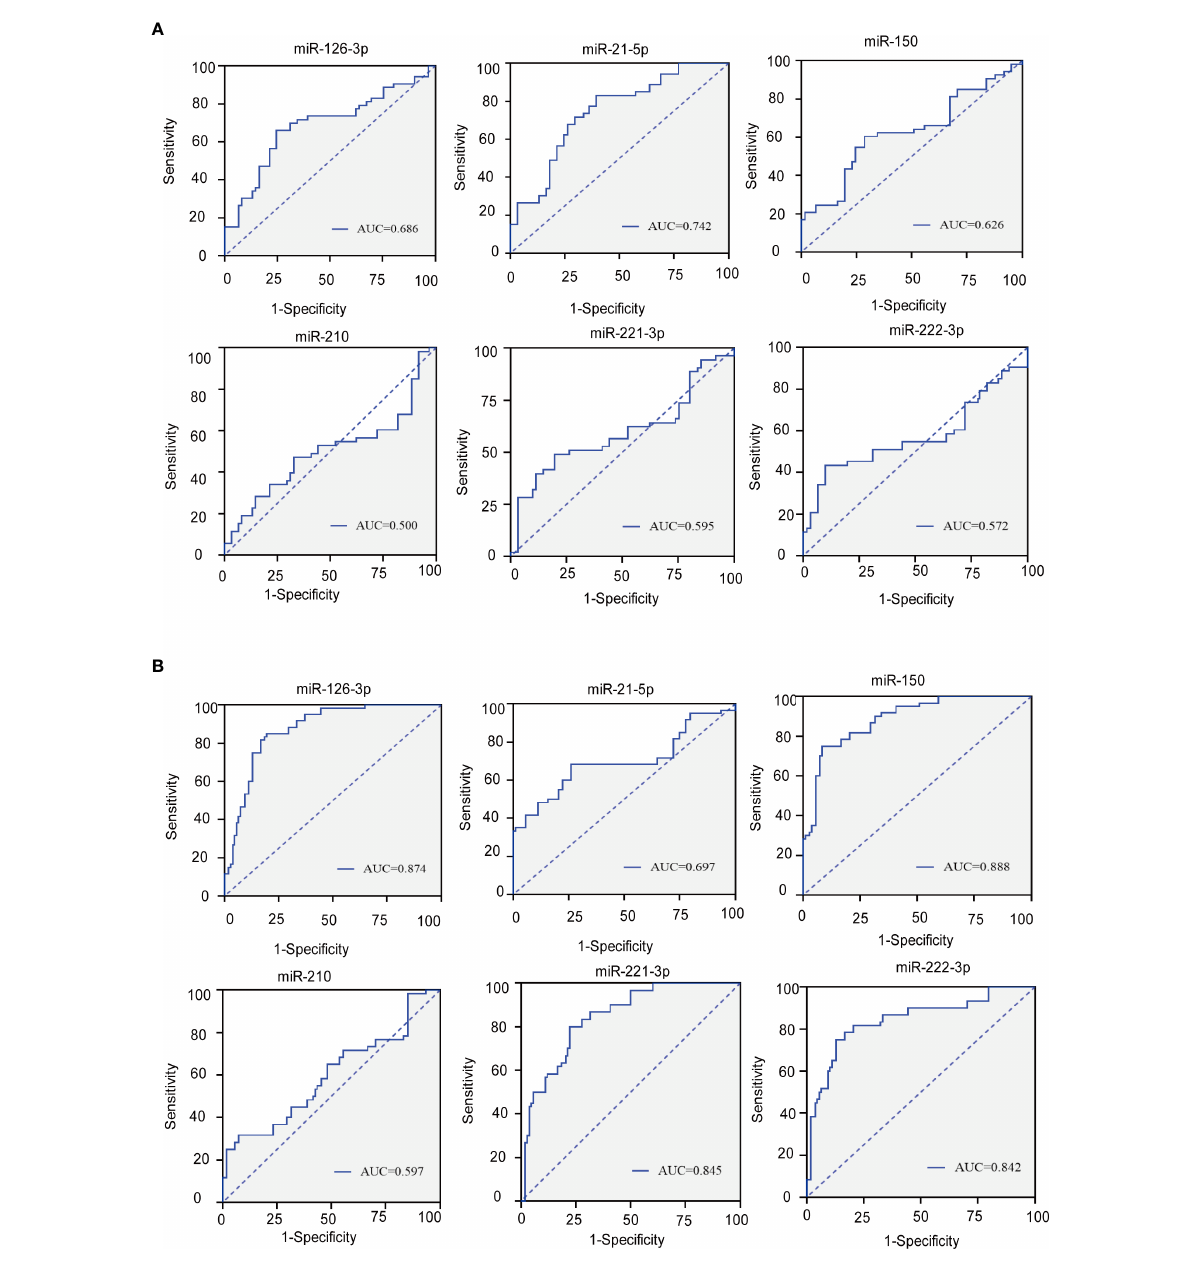
FIGURE 6 (A) Roc curves for six circulating miRNAs to distinguish the all SCH patients (SCH+ATH and SCH) from the (NC and ATH) subject. (B) Roc curves for six circulating miRNAs to distinguish the all ATH patients (SCH+ATH and ATH) from the (NC and SCH) subject. AUC, area under curve; CI, con fi dence